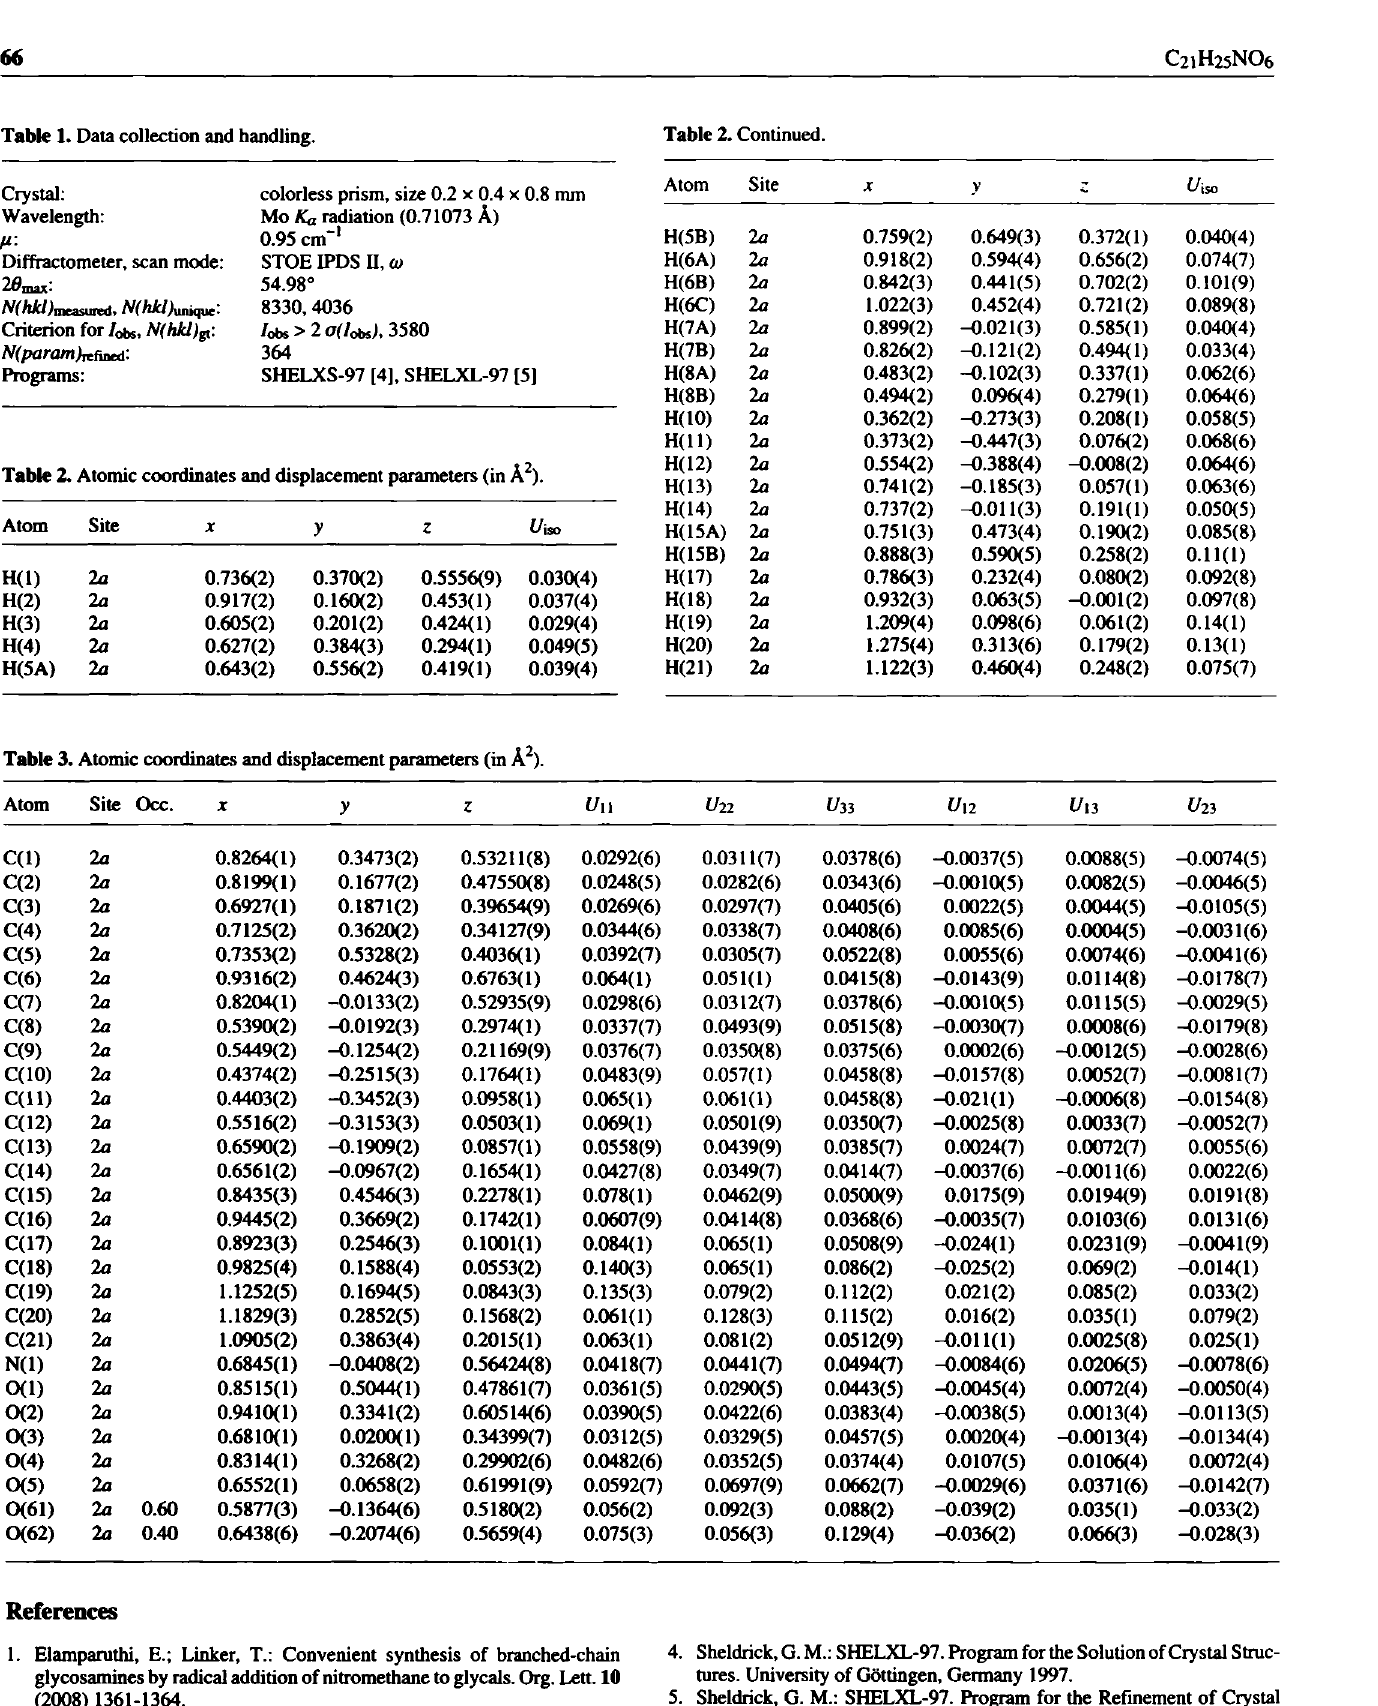
Table 2. Atomic coordinates and displacement parameters (in Â 2 ).